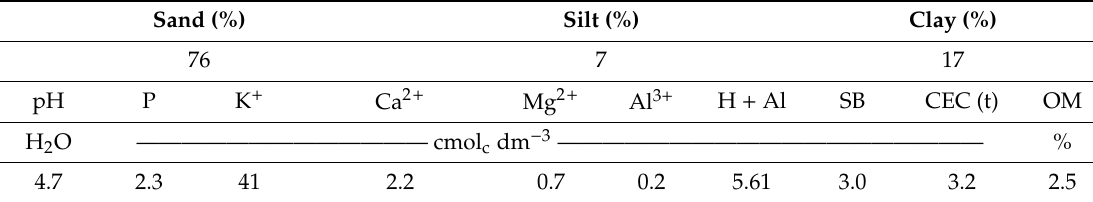
Table 1. Physical and chemical parameters of the red-yellow oxisol used in the experiment. Sand (%) Silt (%) Clay (%) 76 7 17 pH P K + Ca 2 + Mg 2 + Al 3 + H + Al SB CEC (t) OM H 2 O